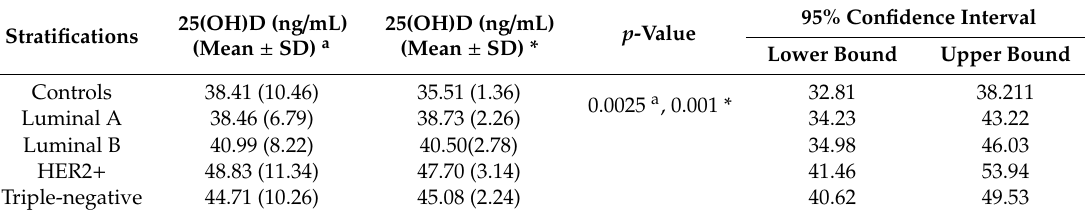
Table 5. Mean 25(OH)D level comparisons among women with low DNA repair capacity levels stratified by molecular subtypes.